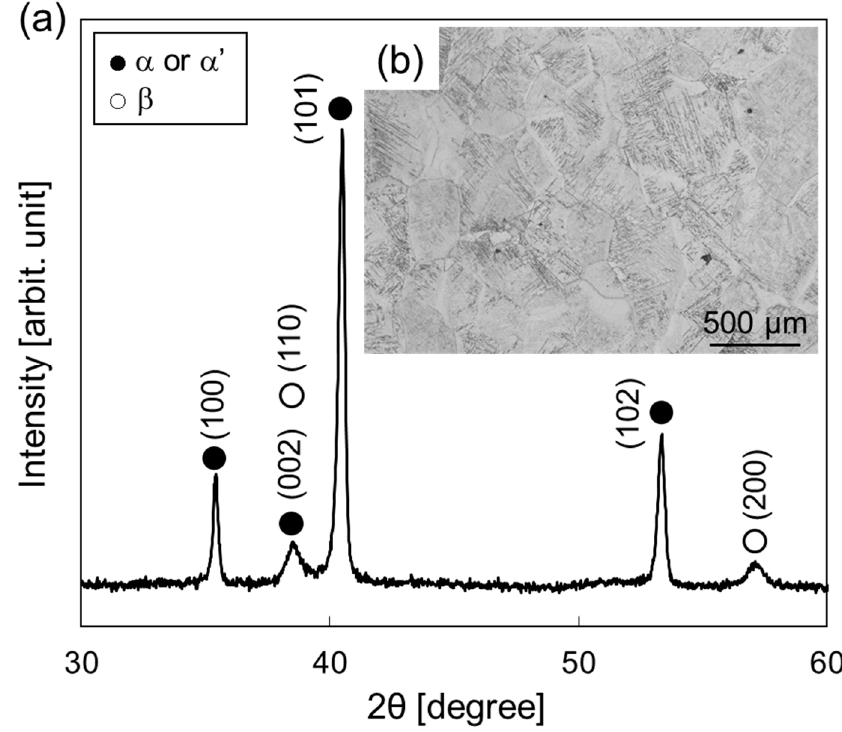
Figure 3. ( a ) XRD pattern and ( b ) optical micrograph of longitudinal sections of the fabricated specimen after heat treatment. In ( b ), the vertical direction corresponds to the building direction.